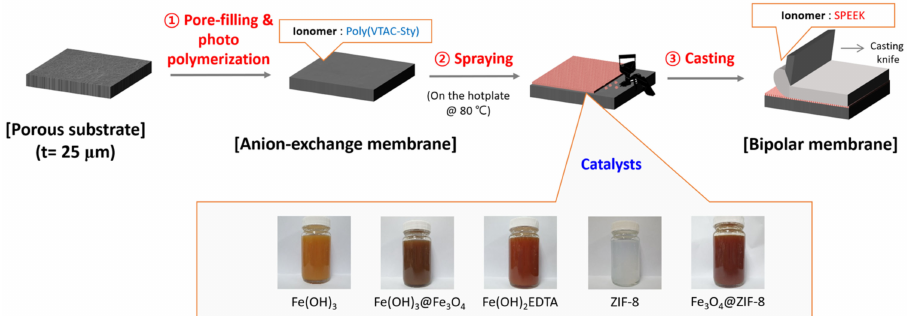
Figure 2. Schematic drawing of BPM fabrication